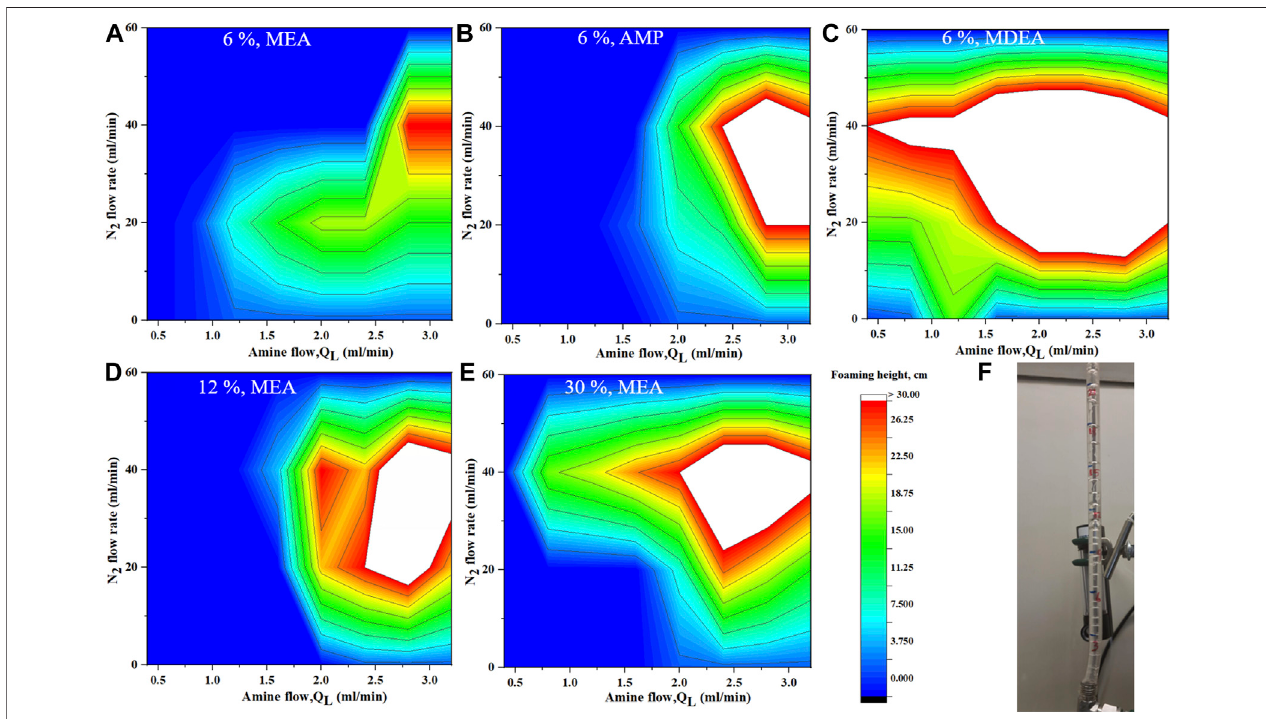
FIGURE 9 | Foaming behavior by varying the amine fl ow rate and N 2 fl ow rate before gas-liquid separator for (A) 6% MEA (B) 6% AMP (C) 6% MDEA (D,E) 12% – 30% MEA (F) lab-scale foam measuring unit connected to the microreactor testing unit on top of the gas-liquid separator.